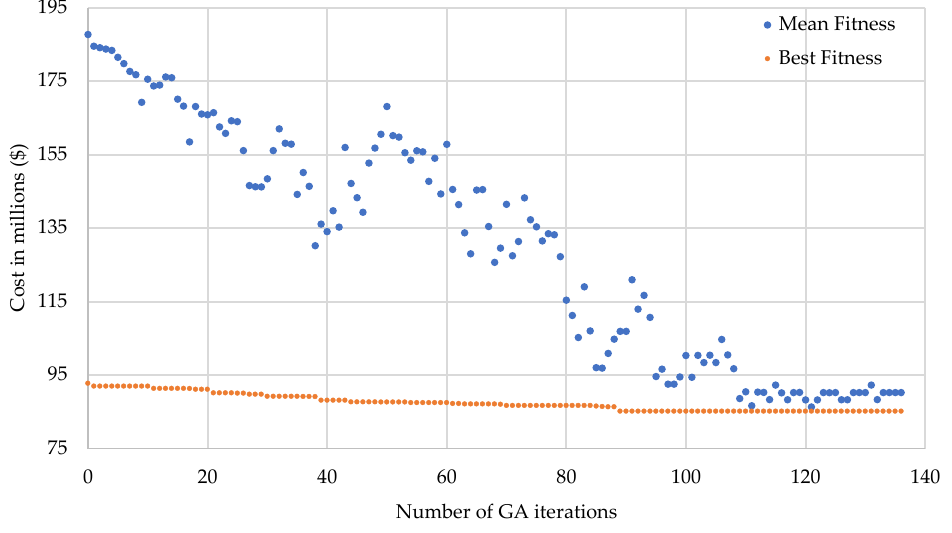
Figure 9. CASE-C GA convergence graph.